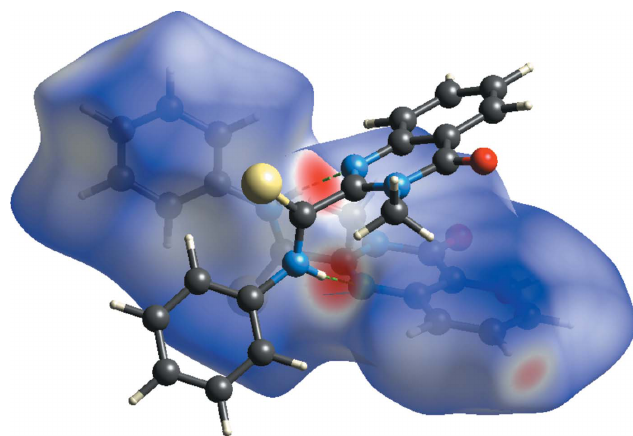
Figure 6 View of the three-dimensional Hirshfeld surface of the title compound plotted over d norm .